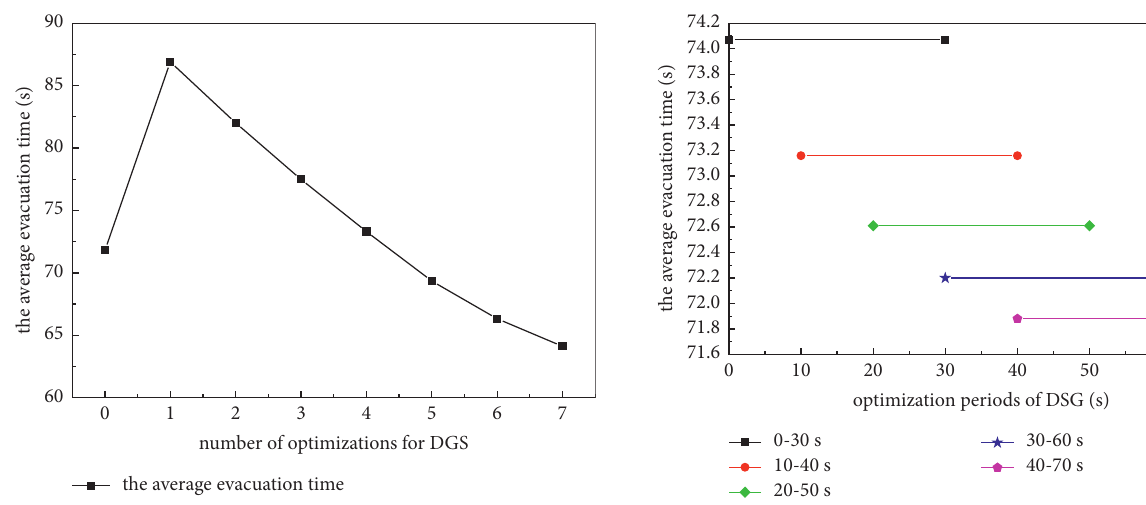
Figure 9: The average evacuation time with DSG in different